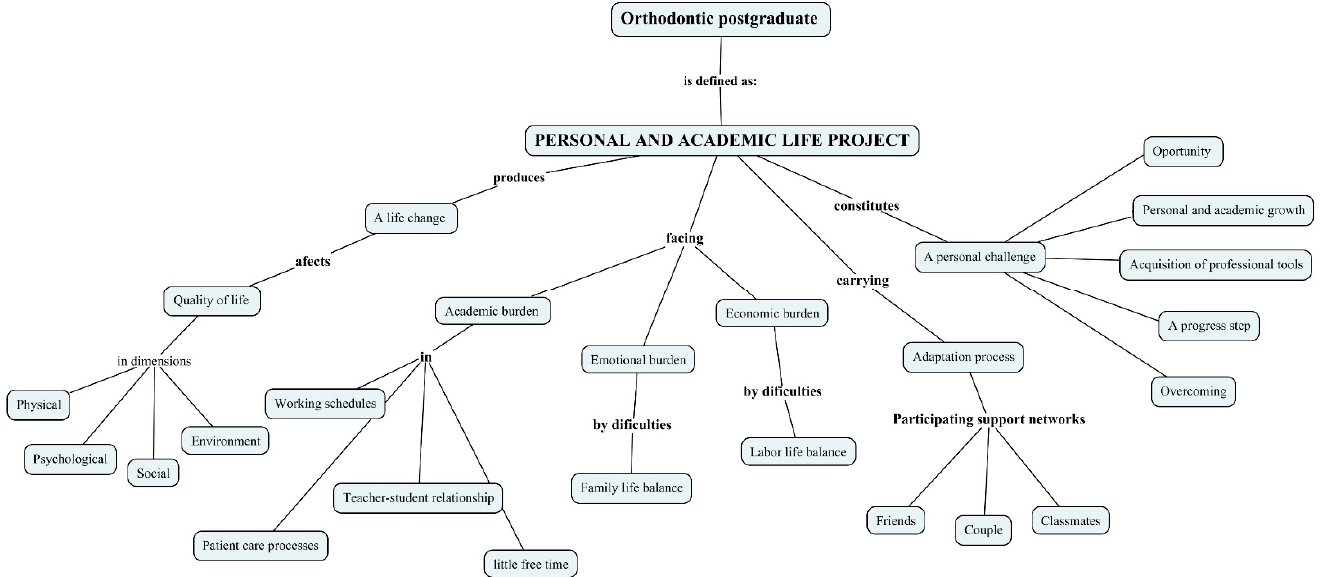
Figure 3. Conceptual map for “a roller coaster ride: the postgraduate training as a personal and academic life project”. Elaborated by using Cmaptools 6.03.01.